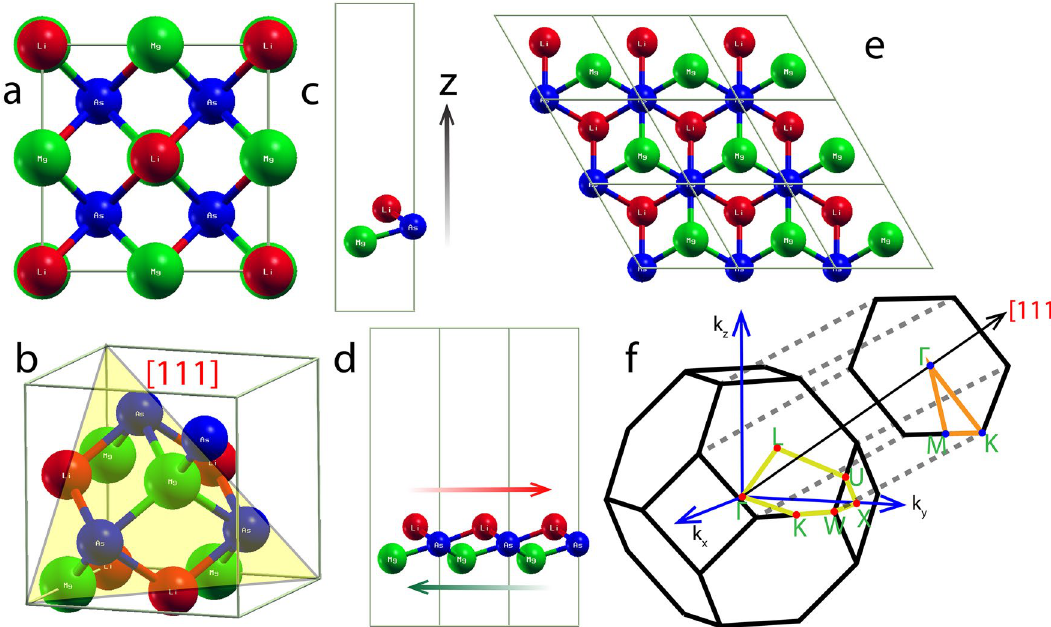
Figure 1. ( a ) Face Centered Cubic (FCC) structure of LiMgAs with; Li, Mg and As placed at, 4 b , 4 c and 4 a Wyckoff positions respectively. ( b ) [111] plane of FCC LiMgAs. ( c ) Quantum confinement achieved by introducing 15 (Å) vacuum along z-direction of the [111] layer of LiMgAs which has structure similar to that of 1T-MoS 2 . ( d and e ) Side and Top views of the low-dimensional supercell. Figure ( d ) indicates the sandwich type structure with, Li atoms placed on top layer shifted towards right (red arrow) and Mg atom place in the bottom layer shifted towards left (green arrow) while the As atoms occupy the middle layer. ( f ) Irreducible first Brillouin Zones with the path for Electronic Band Structure indicated for the bulk and the low-dimensional [111] phase of LiMgAs.